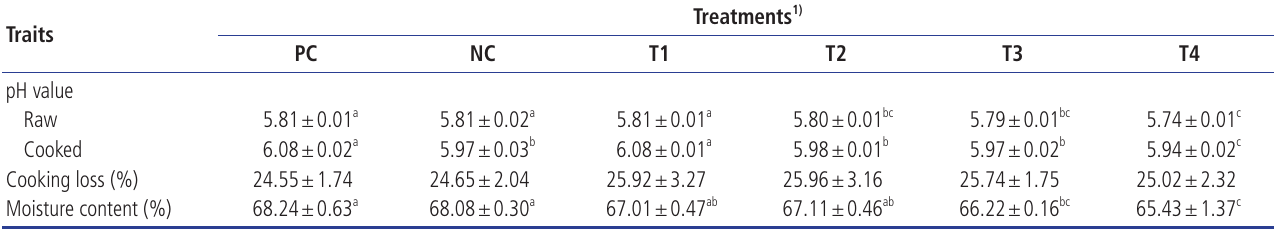
Moisture content